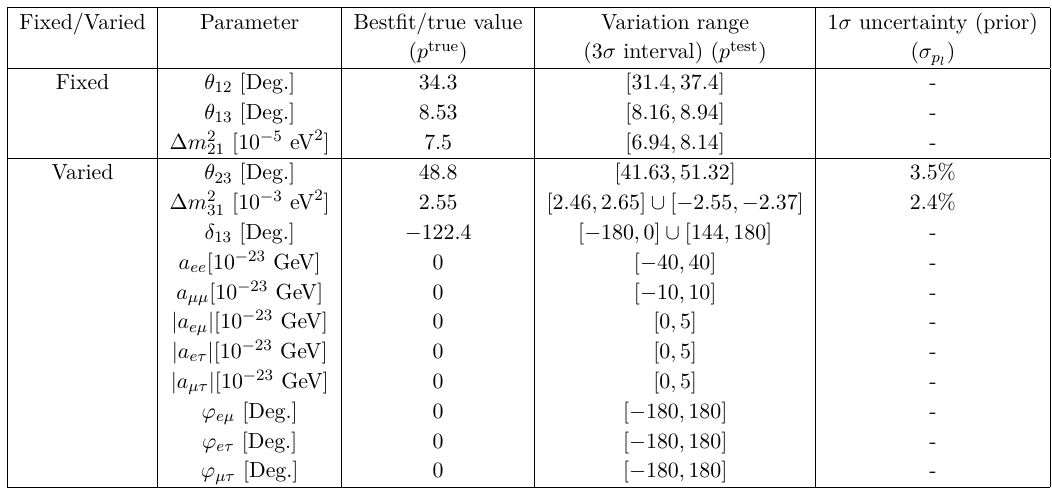
Table 1 . The values of standard and LIV parameters used in our study. The first column indicates whether the parameters were kept fixed or varied around their true values. The third column shows the true values used (taken from the globalfit analysis in [8]), while the next column shows the range of variation (taken to be the current 3 σ interval). The rightmost column shows the prior uncertainties used while varying the corresponding parameters in the analysis. If the 3 σ upper and lower limit of a parameter is x u and x l respectively, the 1 σ uncertainty is ( x u − x l ) / 3( x u + x l )%